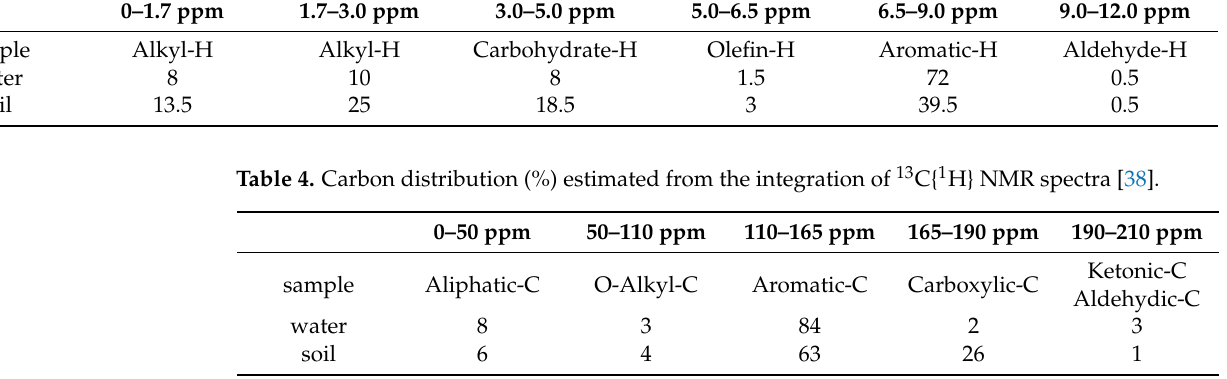
Table 4. Carbon distribution (%) estimated from the integration of 13 C{ 1 H} NMR spectra [38].